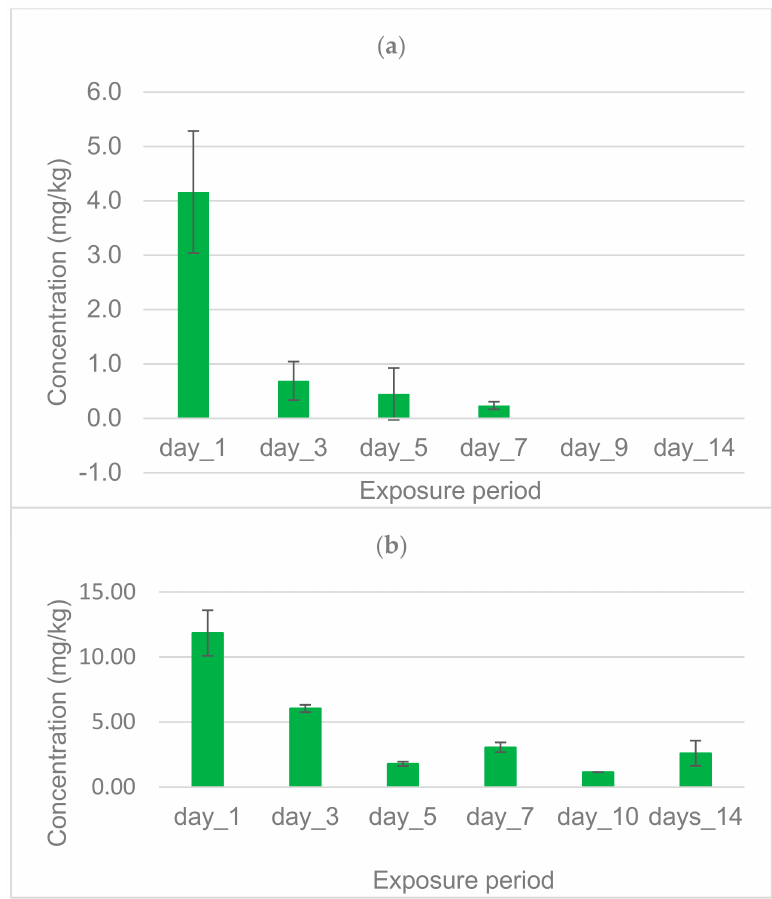
Figure 5. On-farm monitoring of λ -cyhalothrin residues on growing vegetables after insecticide application: ( a ) distribution of λ -cyhalothrin residues on lettuces from Houeyiho; ( b ) Distribution of λ -cyhalothrin residues on cabbages from